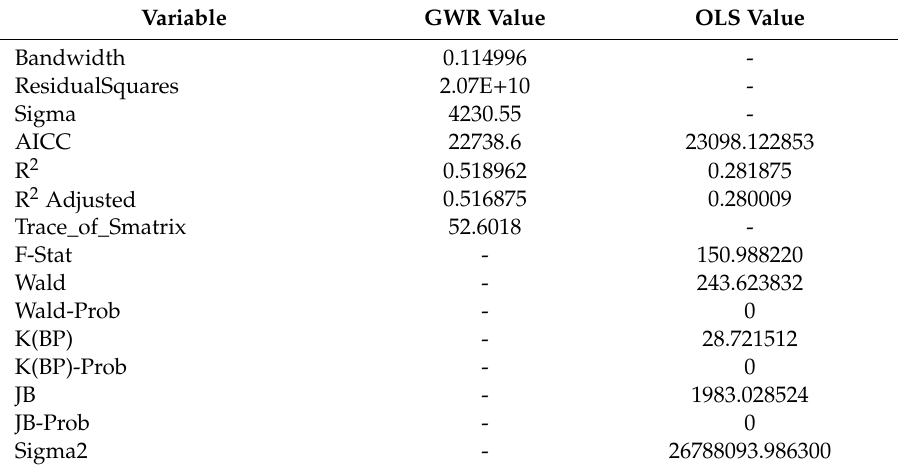
Table 3. Results of Geographically weighted regression (GWR) and Ordinary least square (OLS). Variable GWR Value OLS Value Bandwidth